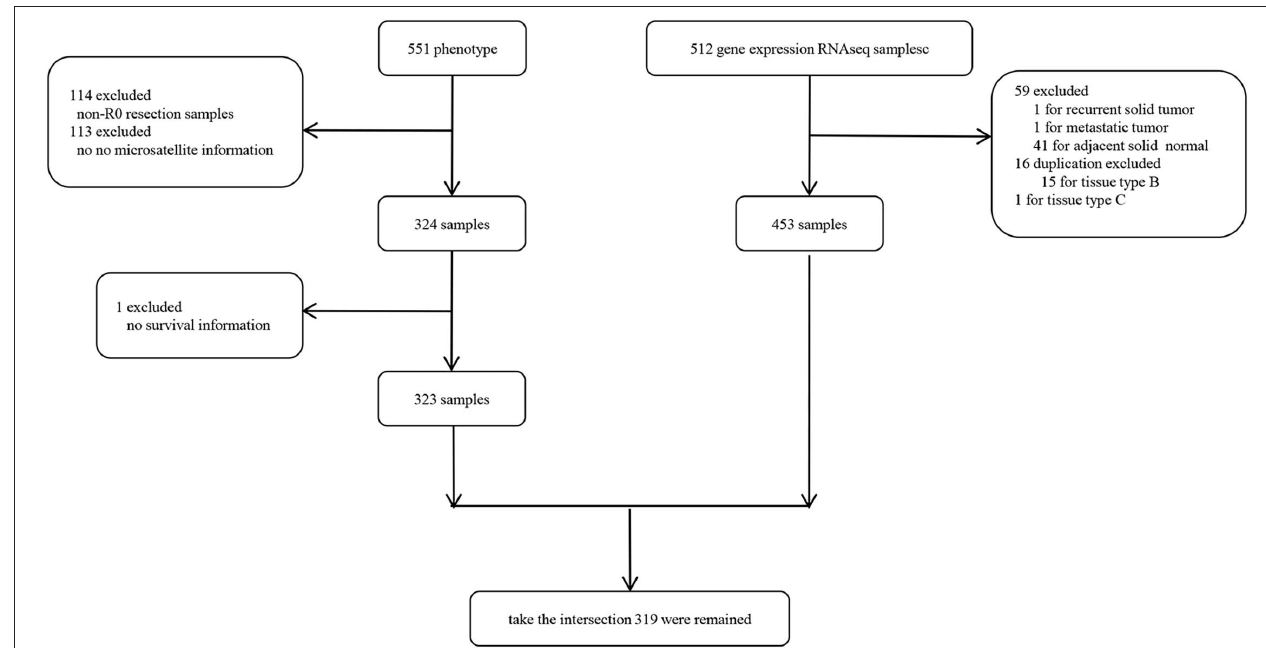
FIGURE 1 | Flowchart of this study.